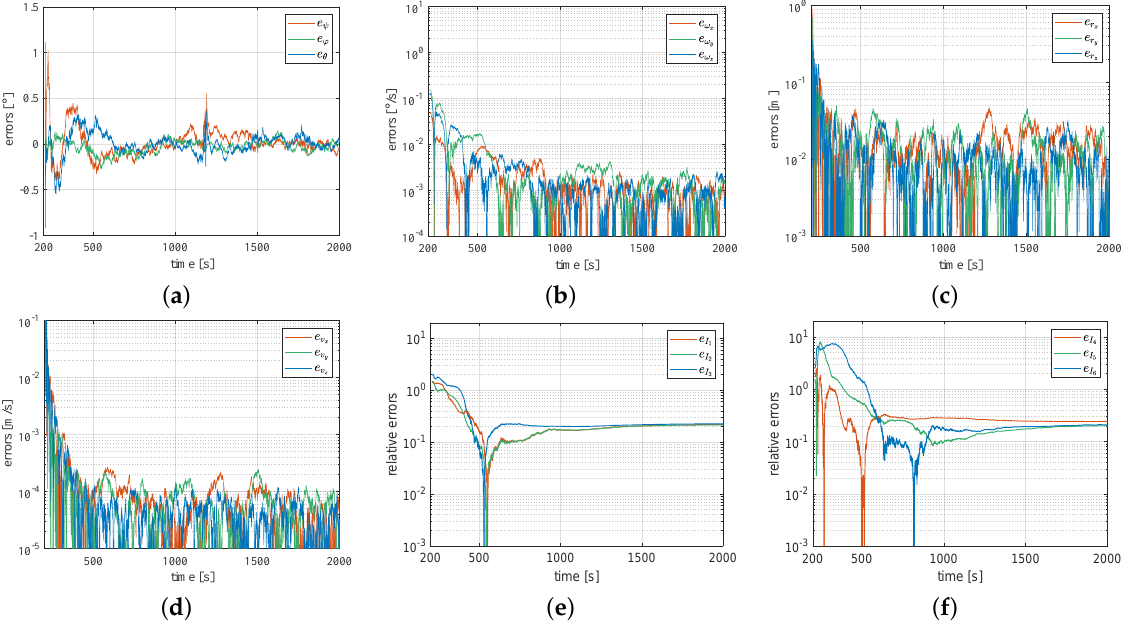
Figure 10. The errors of the estimations after the collision at large distance: ( a ) errors of the Euler angle estimations; ( b ) errors of the angular velocity estimations; ( c ) errors of the relative position estimations; ( d ) errors of the relative velocity estimations; ( e ) errors of the moment of inertia estimations; ( f ) errors of the product of inertia